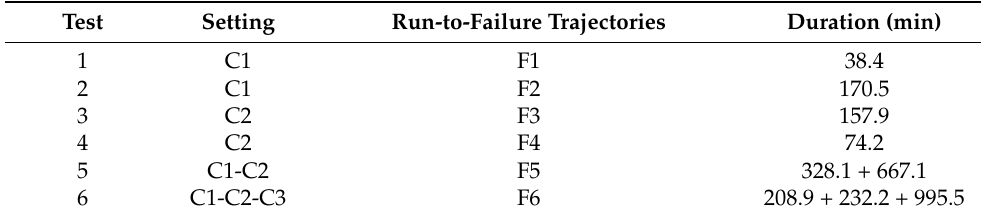
Table 4. Available datasets.